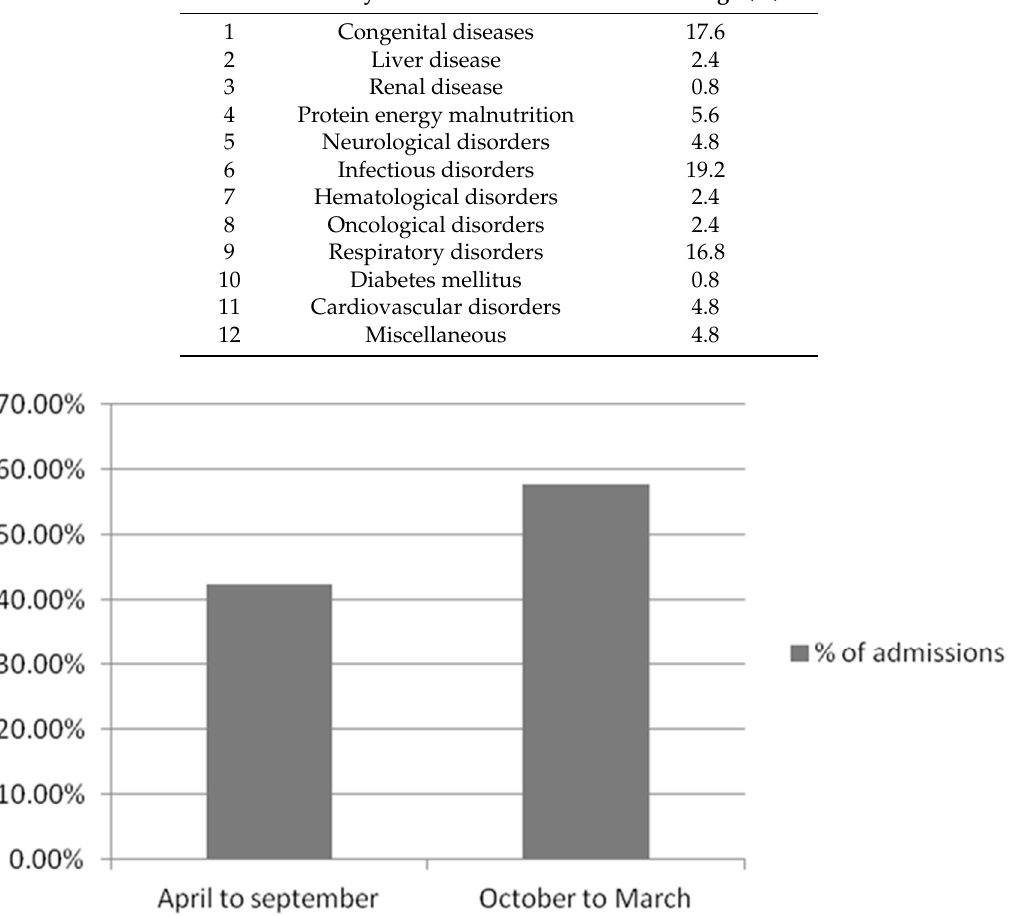
Figure 2. Percentages of admissions in different month.